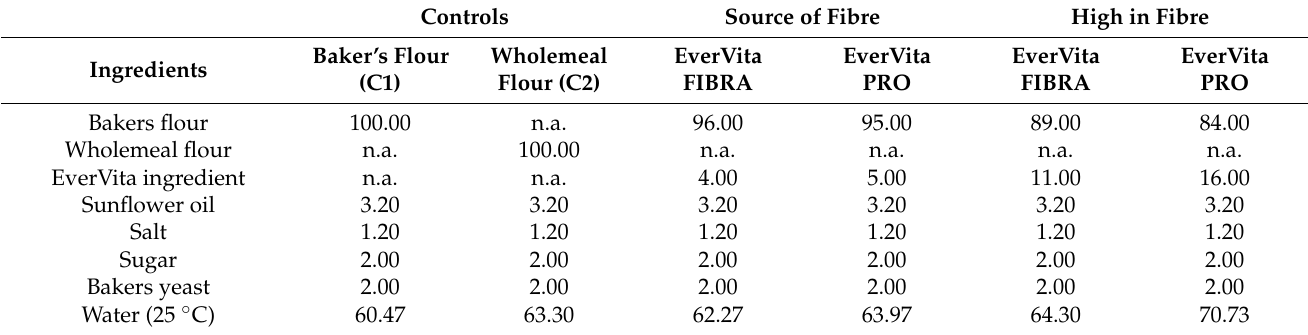
Table 1. Recipes of breads in % based on baker’s flour/wholemeal flour + EverVita ingredient. Controls Source of Fibre High in